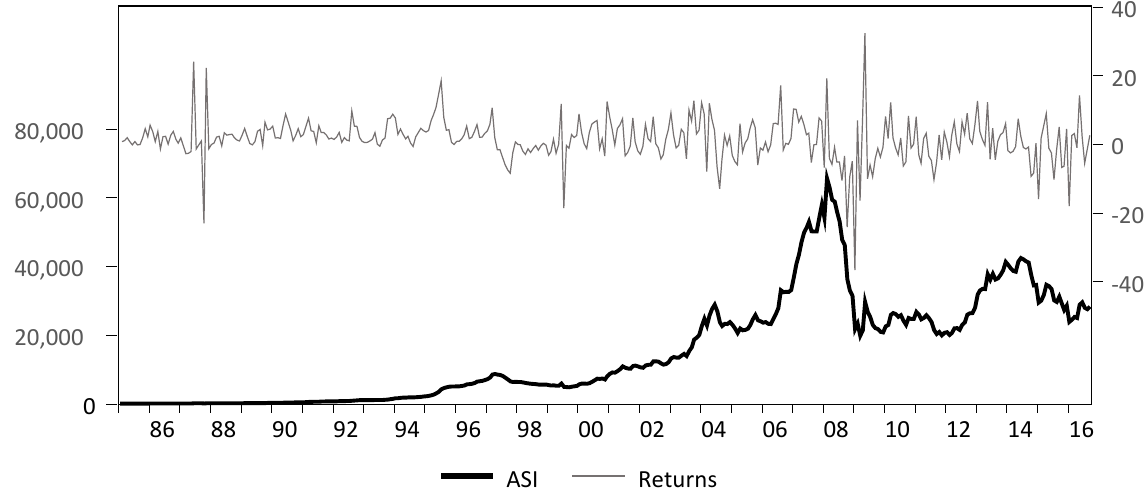
Figure 2. Combined graph of ASI and returns (January 1985 – September